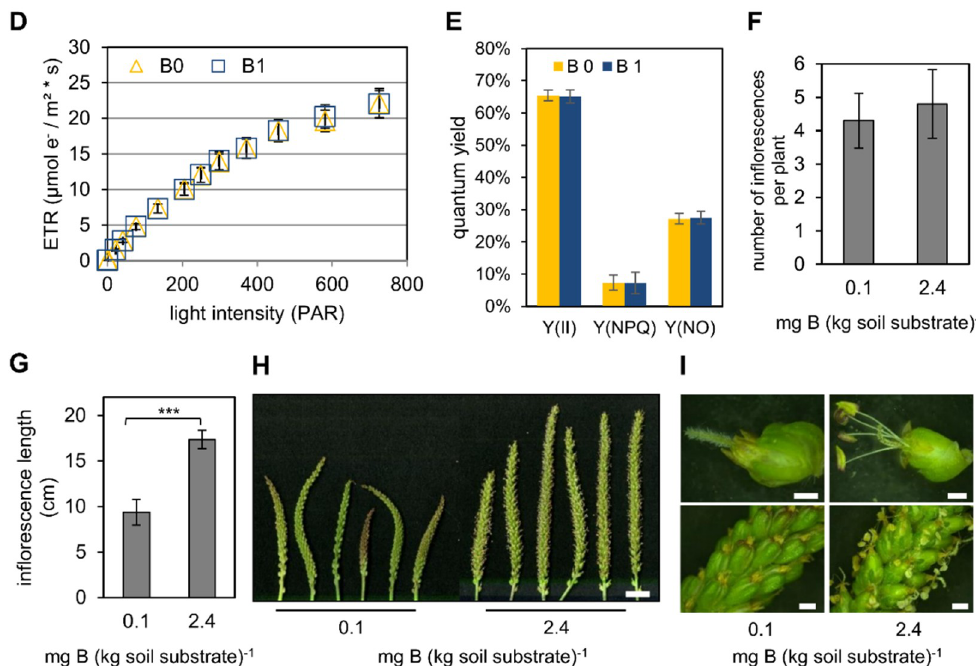
Figure 1. Growth parameters of P. major and pulse amplitude modulated (PAM) fluorometry data. ( A ) Representative pictures of four-week-old P. major plants grown under low B (= B0 = 0.1 mg B (kg soil substrate) −1 ) or normal B conditions (= B1 = 2.4 mg B (kg soil substrate) −1 ). ( B ) Dry weight and ( C ) number of rosette leaves of plants grown at 0.1 or 2.4 mg B (kg soil substrate) −1 . Bars are means from n = 12 plants ± SD. p- value was determined by double-sided t -test. ( D ) Electron transfer rate (ETR) measured on whole rosettes in dependence of light intensity (PAR). Values are means of n = 4 plants per condition ± SE. ( E ) PAM fluorometry parameters. Quantum yields of photosystem II activity [Y(II)], non-photochemical quenching [Y(NPQ)], and non-regulated electron transfer [Y(NO)] are depicted. Bars are means of n = 4 plants ± SE. ( F ) Number of inflorescences per plant and ( G ) average length of inflorescences from plants grown at 0.1 or 2.4 mg B (kg soil substrate) −1 . Values are means from n = 12 plants ± SD. Asterisks represent p -value < 0.001 according to double-sided t -test. ( H ) Representative inflorescences from plants grown at 0.1 or 2.4 mg B (kg soil substrate) −1 . White scale bar is 1.8 cm. ( I ) Representative pictures from flowers (upper two pictures) and magnified inflorescences (lower two pictures) from plants grown at 0.1 or 2.4 mg B (kg soil substrate) −1 . White scale bars are 4 mm (flowers) and 25 mm (inflorescences).